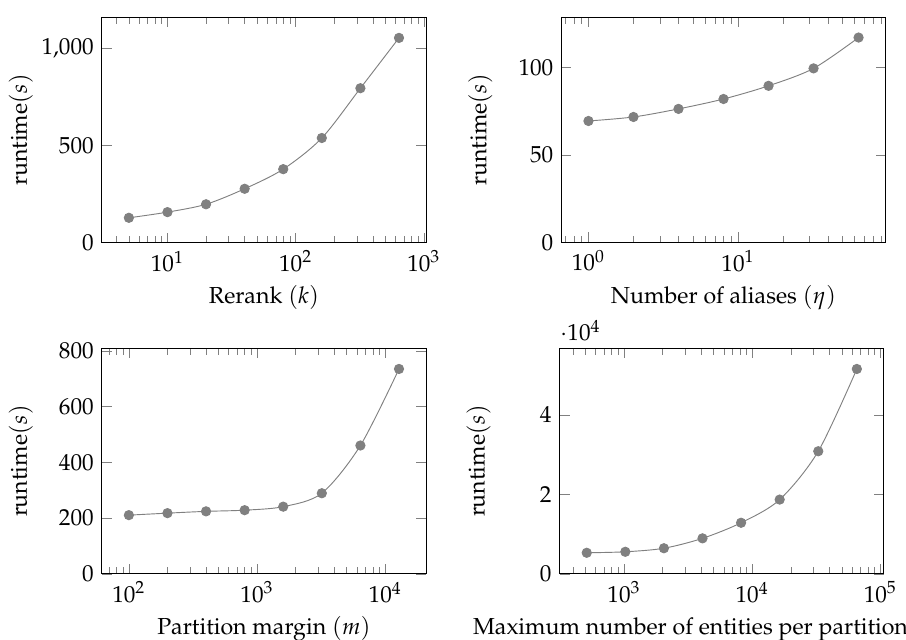
Figure 7. Evaluation of the impact of variables rerank k ( top-left ), number of aliases η ( top-right ), the partition margin m ( bottom-left ) and maximum number of entities per partition N W ( bottom-right ) on the alignment runtime.